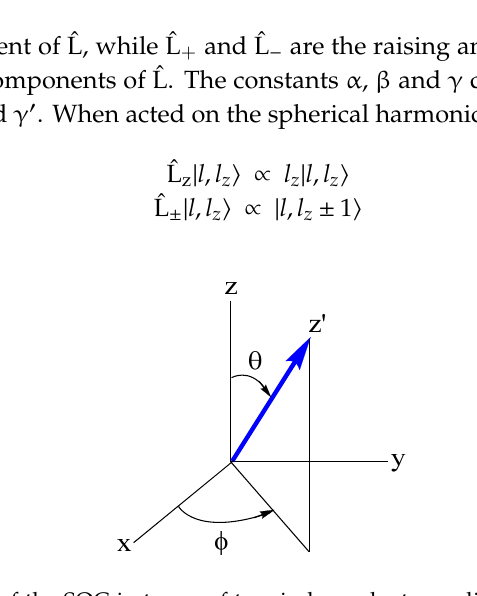
Figure 16. Description of the SOC in terms of two independent coordinate systems; (x, y, z) for L and (x ′ , y ′ , z ′ ) for S , where the z ′ -axis is the spin orientation. That is, ˆL z does not alter the orbital character of | l , l z (cid:105) , but ˆL + and ˆL − do. ˆL + raises the l z value by 1, and ˆL − lowers the l z value by